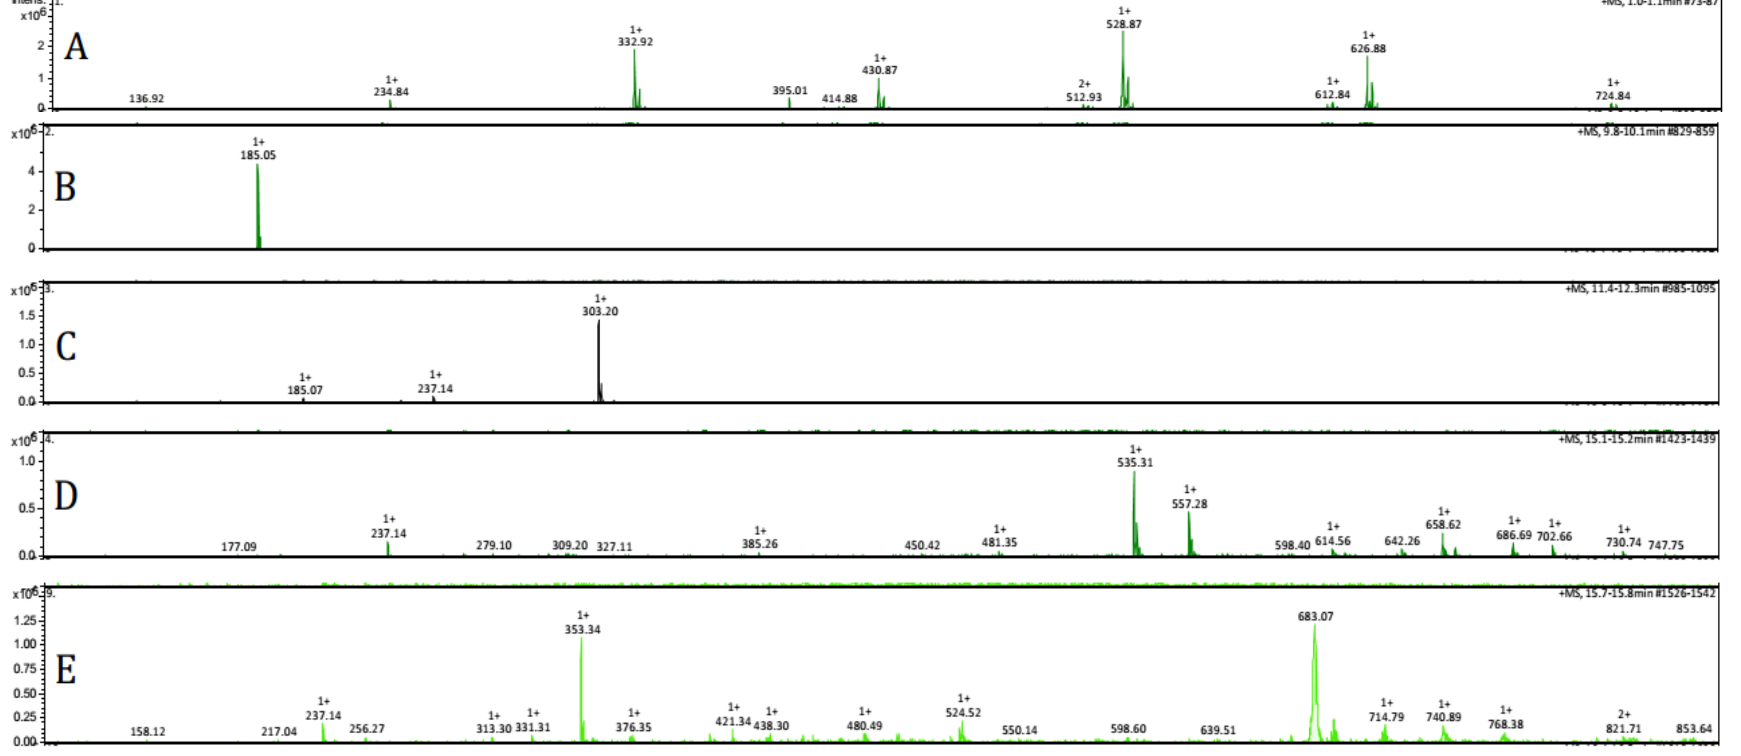
Figure 11. Mass spectra of the fluorescent components detected in the supernatant solutions, corresponding to the retention times peaks of 1.1 min ( A ), 9.9 min ( B ), 11.7 min ( C ), 15.1 min ( D ), and 15.7 min ( E ).